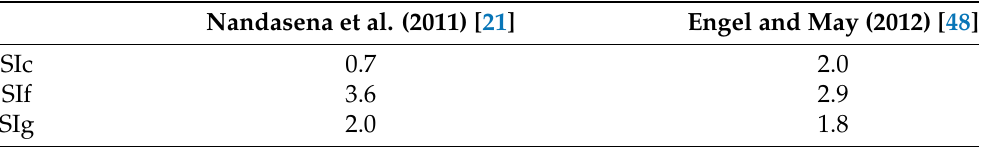
Minimum wave heights H m (m) required to displace the boulders of the Torre Sant’Isidoro